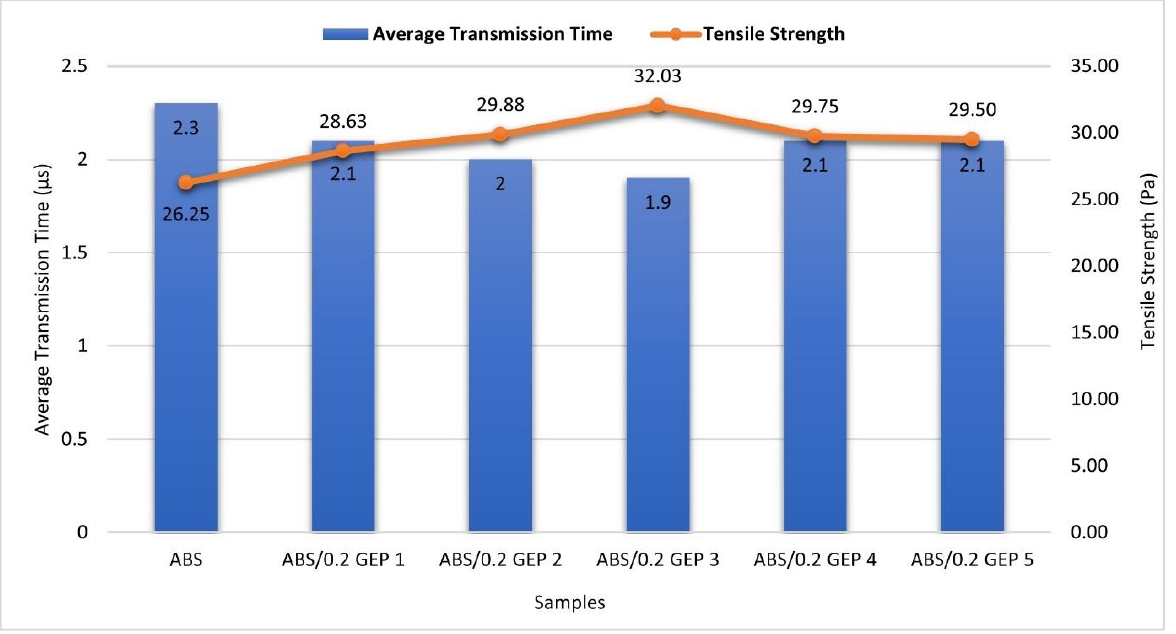
Figure 14. Correlation between average transmission times and tensile strength for ABS/0.2 GEP composites.